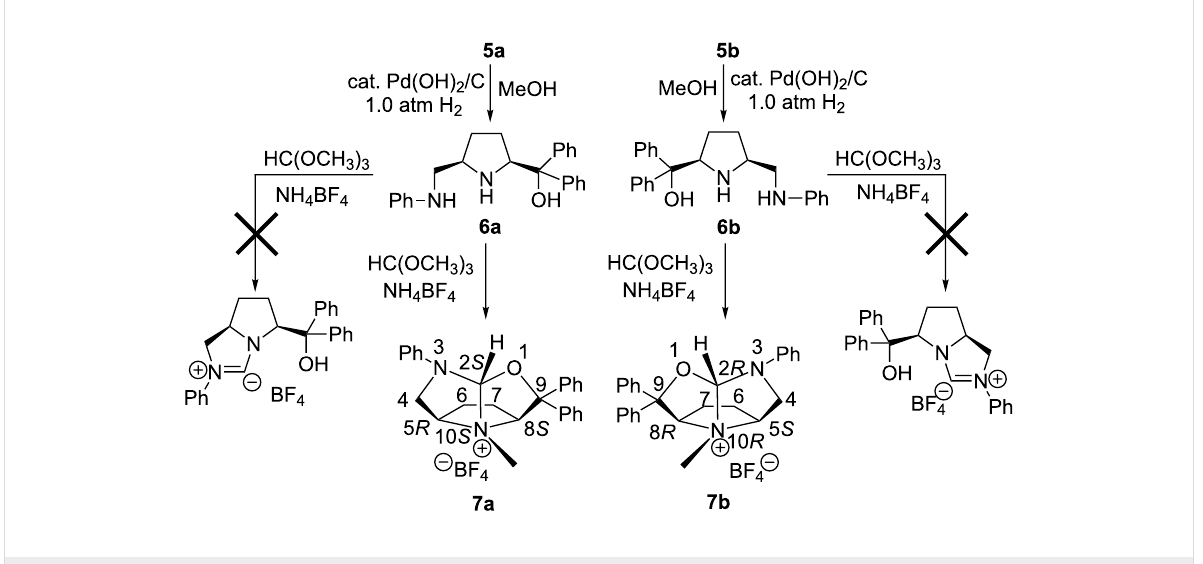
Scheme 3: One-pot tandem cyclization of 6 in the presence of HC(OCH 3 ) 3 .